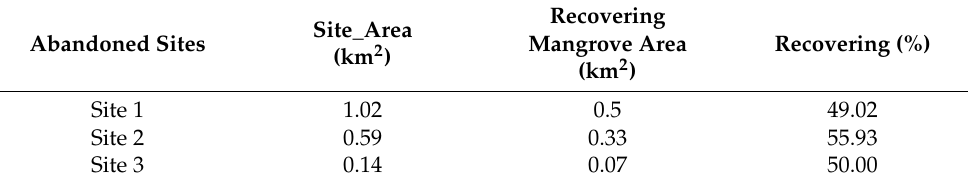
Table 6. Naturally recovering percentage of mangrove at different abandoned shrimp